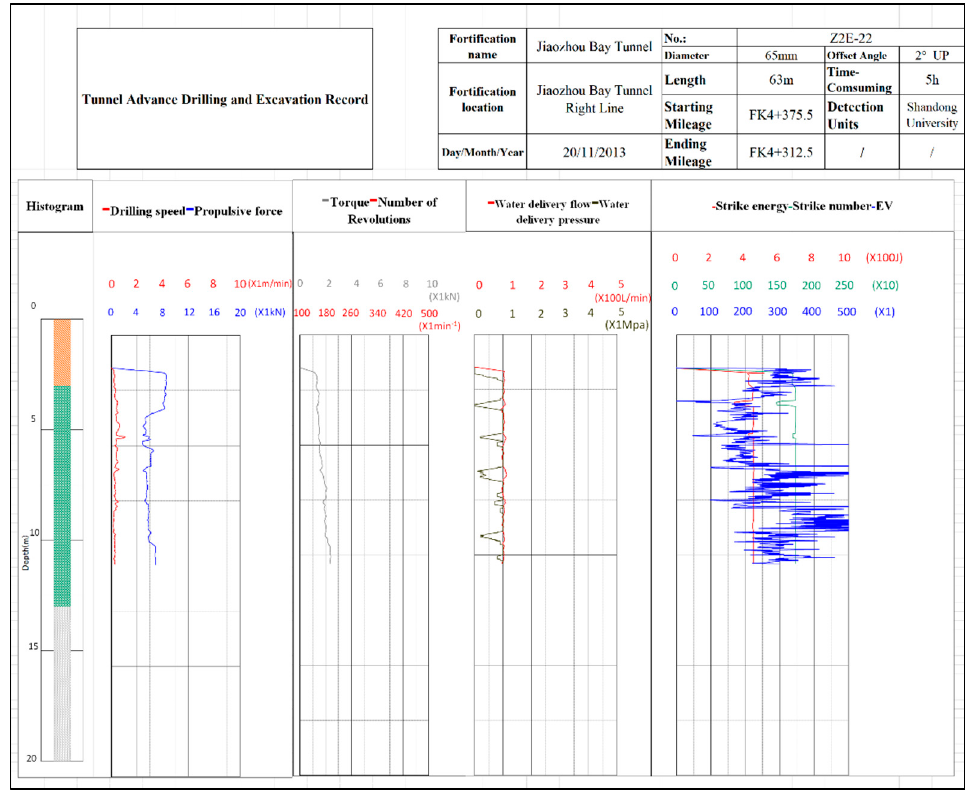
Figure 4. Digital drilling rig parameter acquisition interface. Table 1. Drilling parameters.